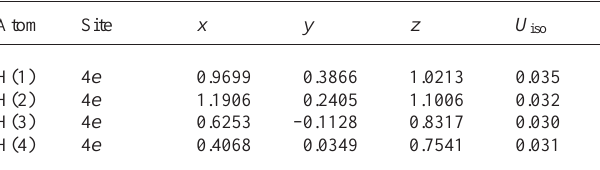
Table 2. Atomic coordinates and displacement parameters (in Å 2 ) .